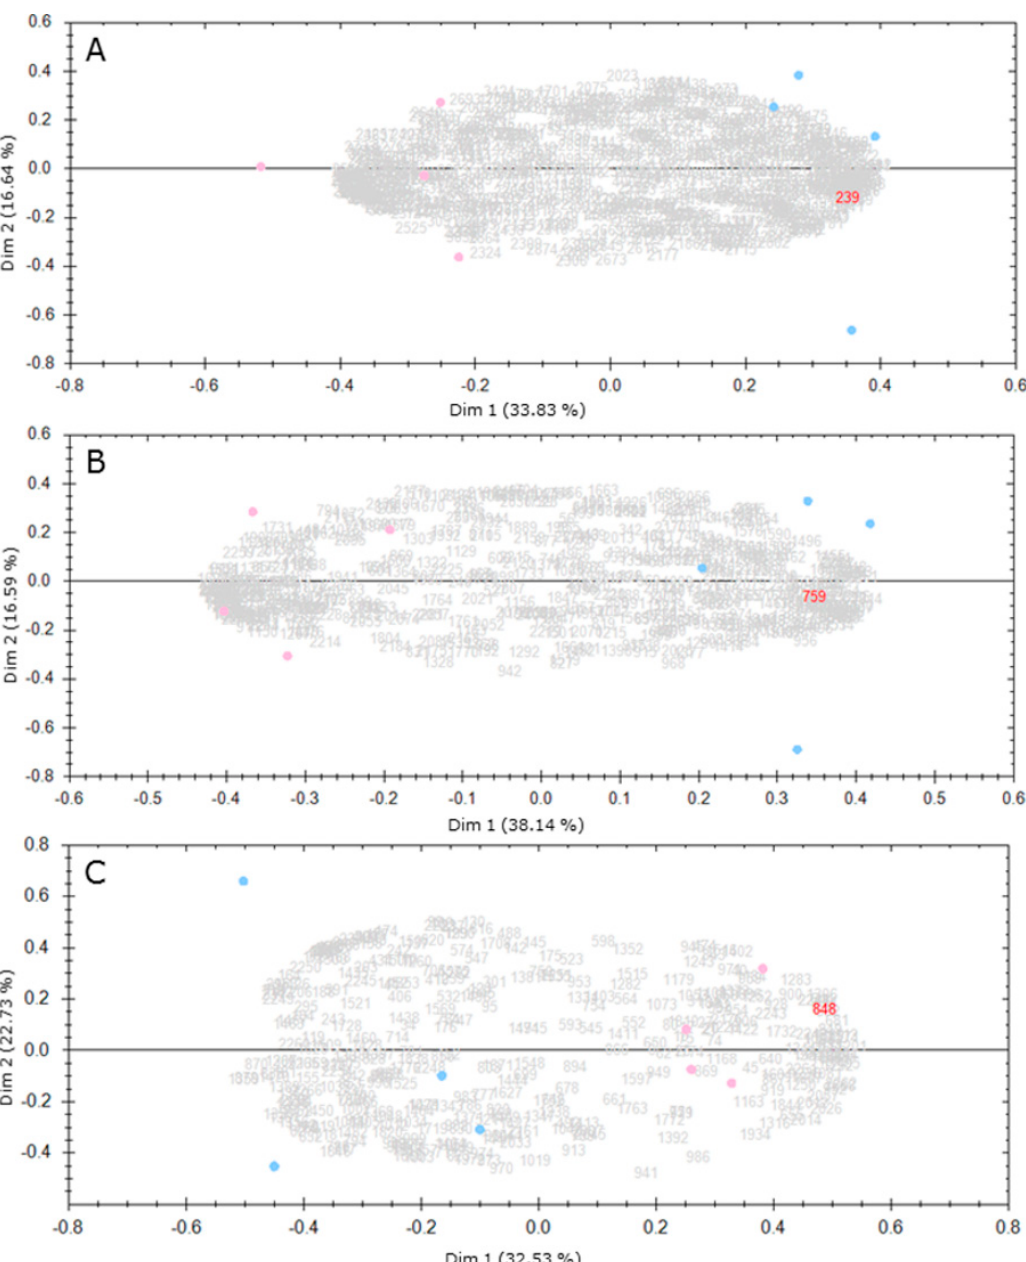
Figure 1. PCA analysis of the gel-based spot intensity data from the three cell wall protein-enriched fractions. ( A ) CaCl 2 ; ( B ) EGTA; ( C ) LiCl. Statistical analysis was done with SameSpots software (TotalLab). Blue dots represent the four biological replicates of the control. Pink dots represent the four biological replicates of Cd-exposed samples. Grey and red numbers correspond to spot numbers considered for the statistical analysis.